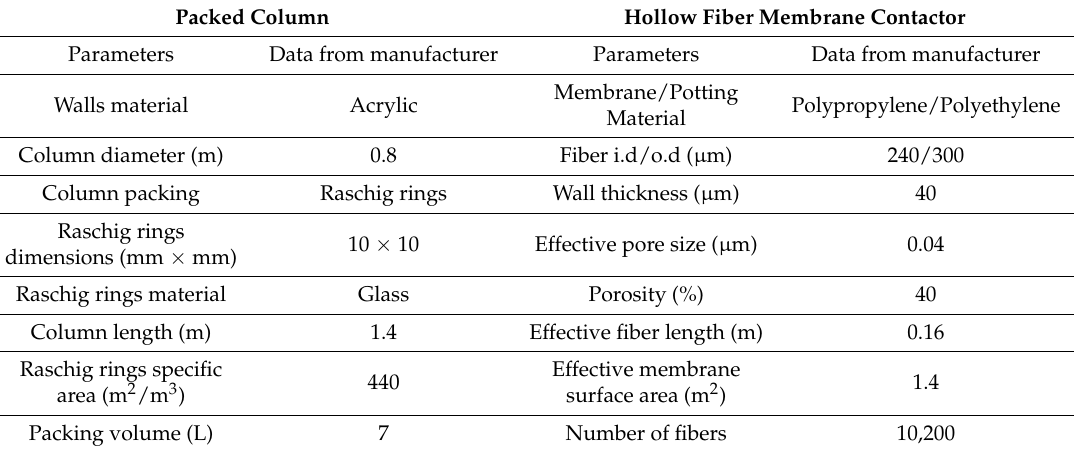
Table 1. Characteristics of the packed column and the hollow fiber